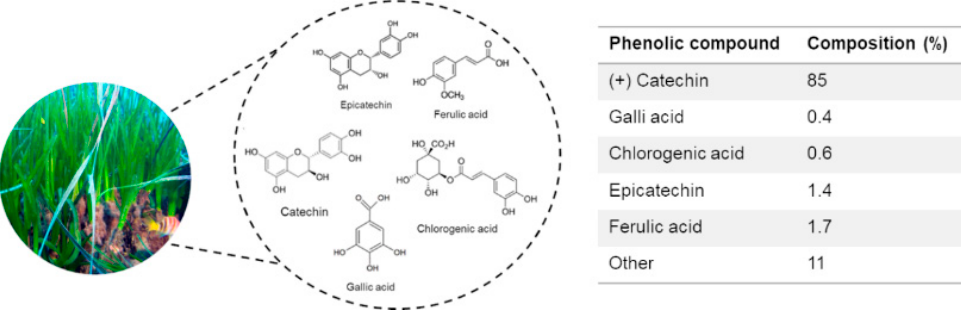
Figure 1. Phenolic composition with relative percentages of P. oceanica leaf extract (POE) obtained by UPLC analysis [5].